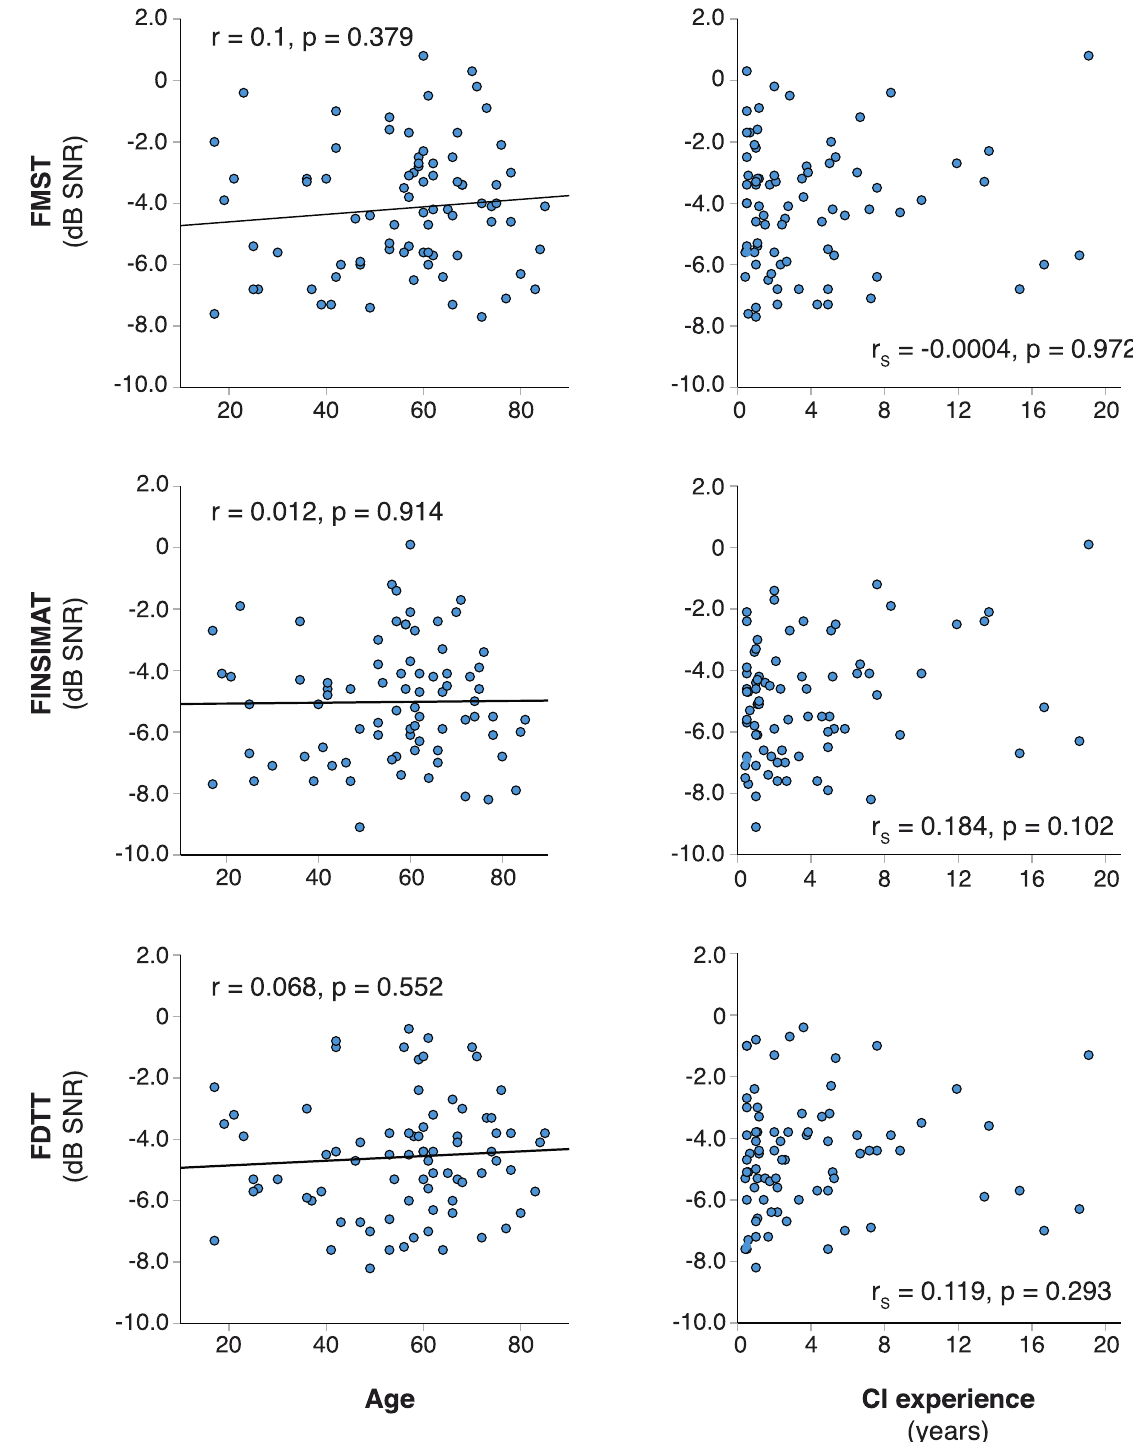
Figure 2. Age and cochlear implant (CI) experience plotted against the speech reception threshold (SRT) estimates for all three tests. For correlations to age, a linear regression is plotted as a solid line, and Pearson correlation coefficients (r) with corresponding p -values are included. Spearman’s rank-order correlation coefficient (r S ) was used for CI experience data.